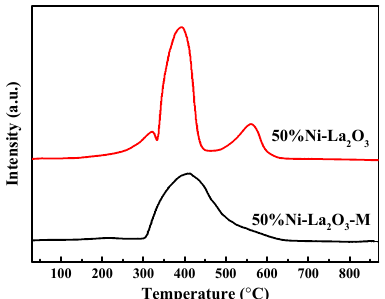
Figure 4. H 2 -temperature programmed reduction (H 2 -TPR) curves of 50% Ni–La 2 O 3 –M and 50% Ni–La 2 O 3 catalysts.